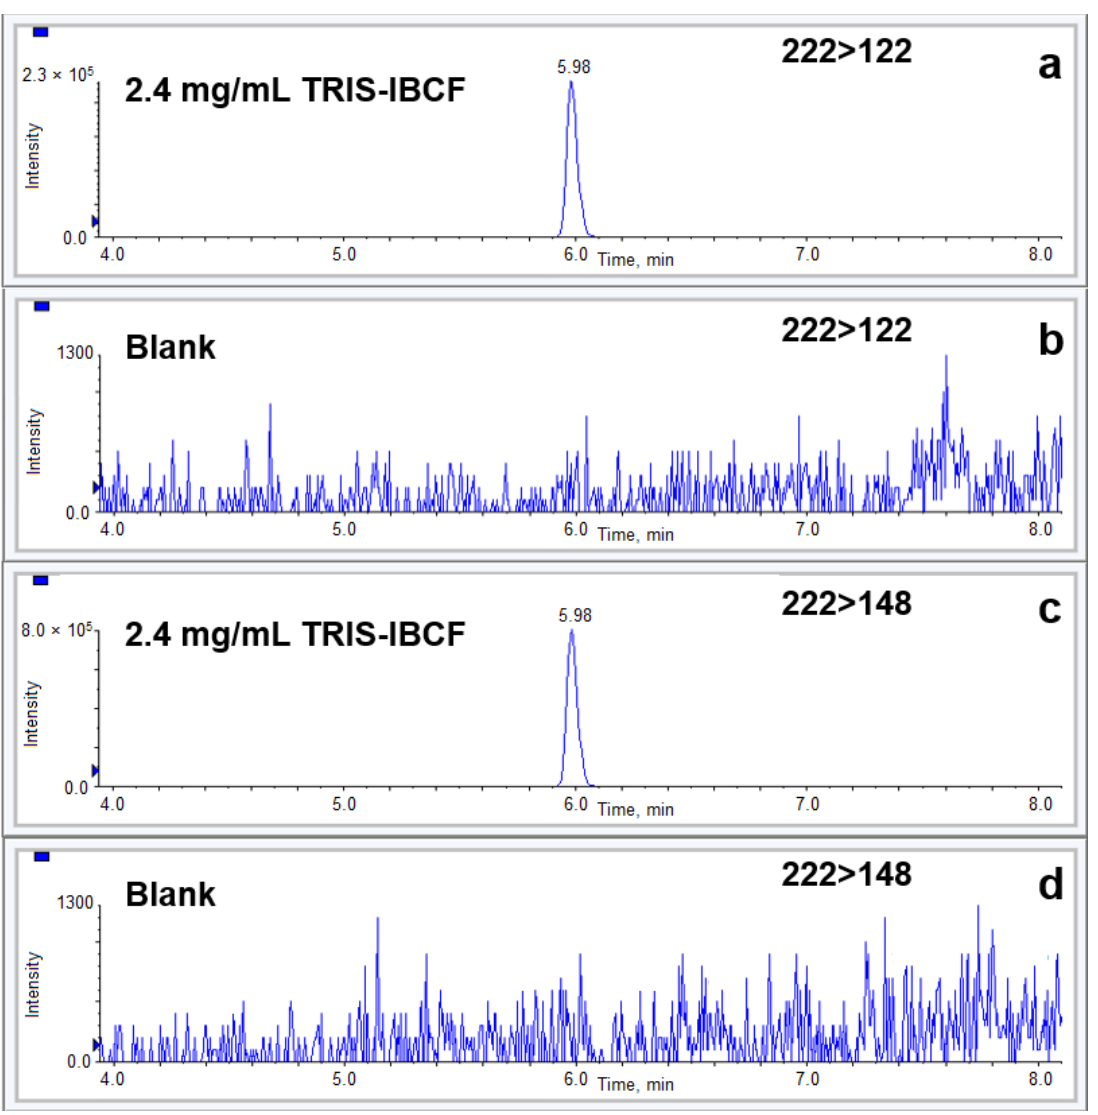
Figure 4. Representative MRM chromatograms of 2.4 mg/mL TRIS-IBCF in the vaccine formulation: a quantifier MRM chromatogram 222 → 122 ( a ) and a qualifier MRM chromatogram 222 → 148 ( c ) along with a blank MTRX (vaccine formulation without Tris (( b ) and ( d ), corresponding to ( a ) and ( c )).